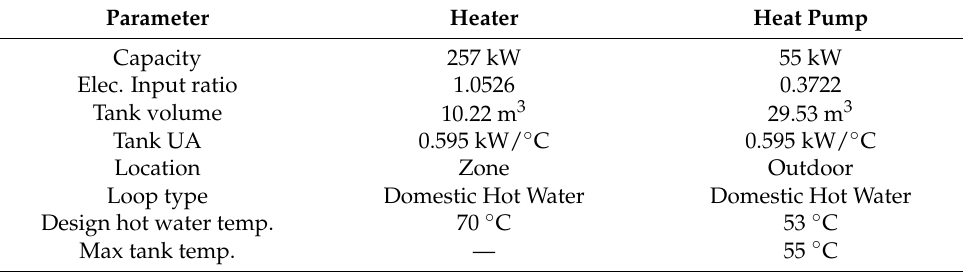
Table 2. Typical input parameters of equipment for building